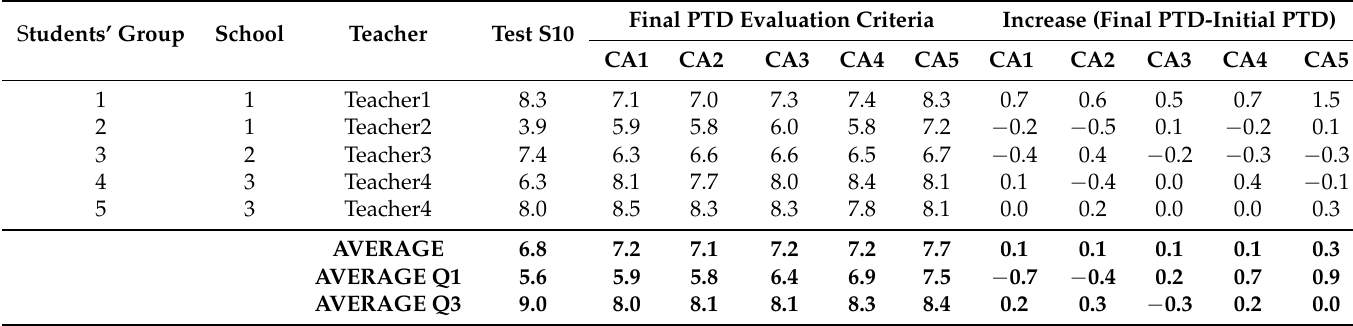
Table 2. Averaged grades for each group of fifteen students during the training (N = 75): The grading scale ranges from 1 to 10, with 10 being the highest grade. The Positive Technological Development (PTD) evaluation criteria correspond to communication (CA1), collaboration (CA2), content creation (CA3), creativity (CA4), and choice of conduct (CA5). The averaged first and third quartiles of the students’ group (Q1 and Q3) are also